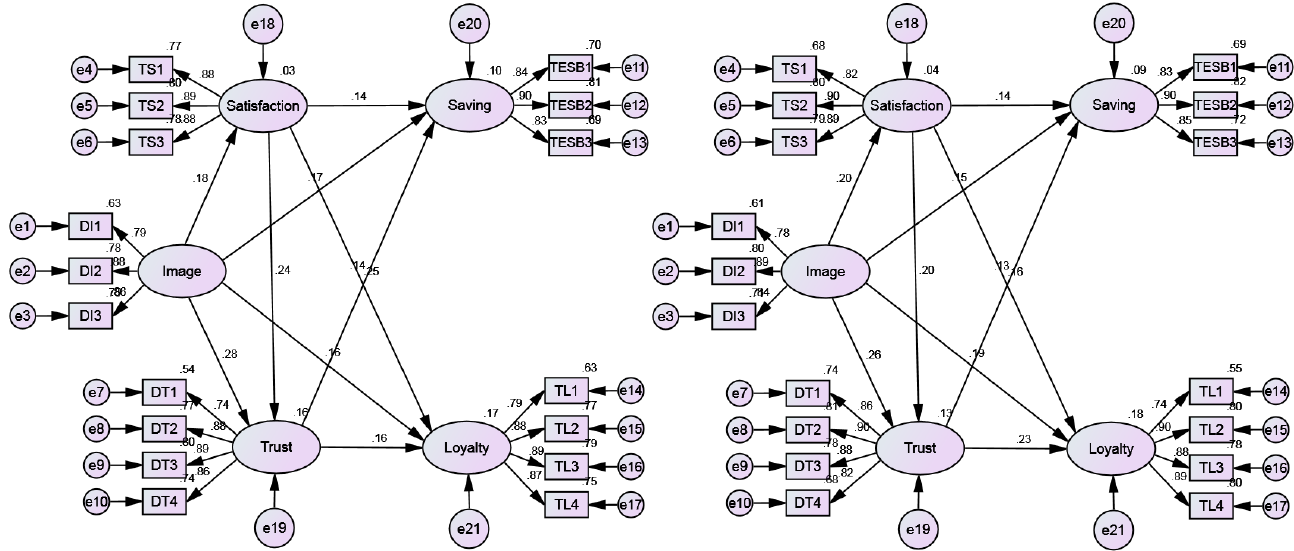
Figure 3. Output results of AMOS in rural ( Left ) and urban ( Right ) contexts .